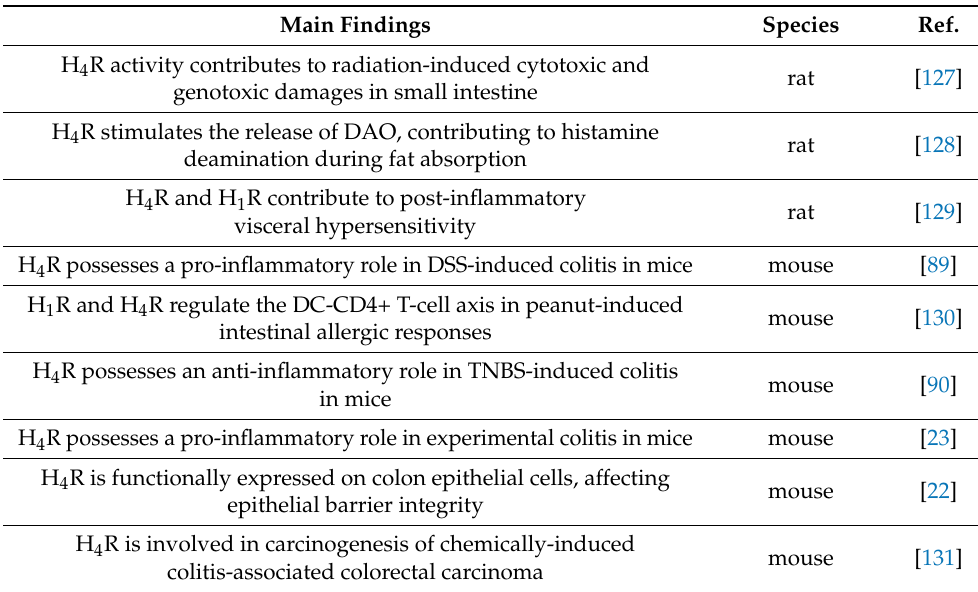
Table 2. Cont . Main Findings Species